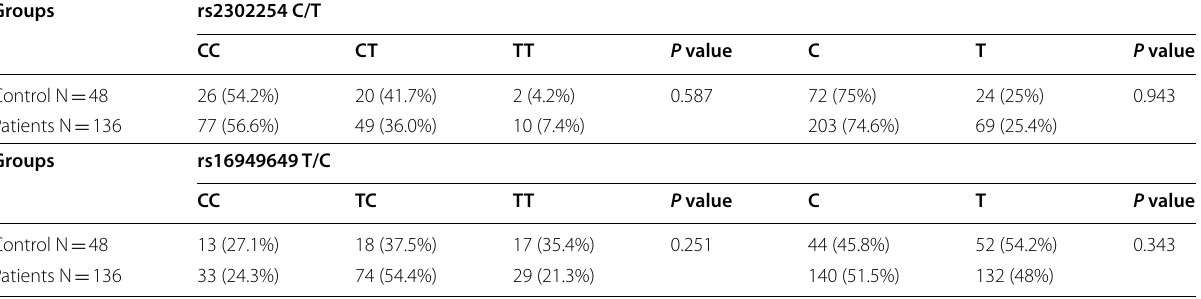
N sample size, p =